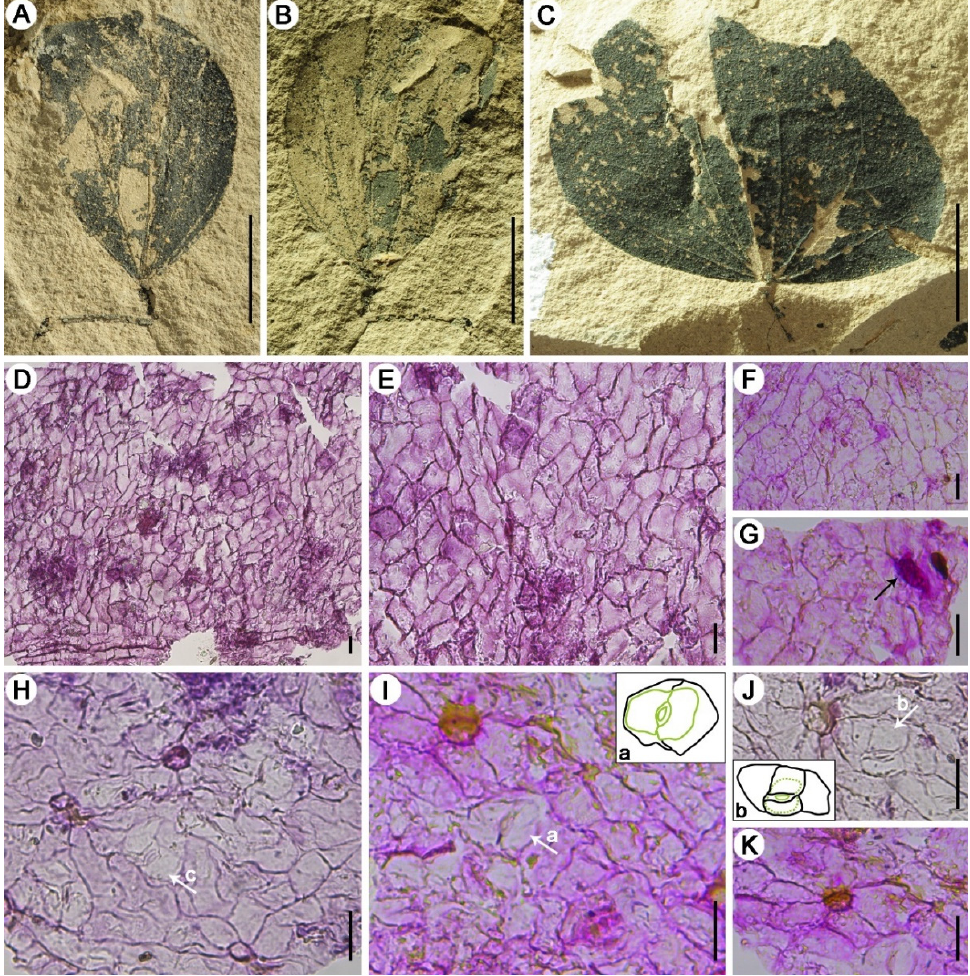
Figure 5. Leaf morphologies and cuticular structures of Bauhinia sp. (morphotype 2) from the Puyang Basin, Funing, Yunnan province. The scale bars represent 1 cm for leaf fossils and 20 μ m for cuticle images. ( A – C ) Leaves of Bauhinia sp. The cuticle images in D, E, H, and J are from the fossil specimen in C; F, G, I, and K are from the fossil specimen in A. ( D – G ) Adaxial cuticle showing straight arched epidermal walls. The black arrow in G indicates a single-celled trichome base. ( H – J ) Abaxial cuticle showing the orientation of stomata. White arrows indicate (a) paracytic stomatal complex with double-layered stomatal rim, (b) tetracytic stomatal complex, and (c) stomatal complex with double-layered stomatal rim. Line drawings illustrate (a) the paracytic stomatal complex indicated with white arrow a, (b) the tetracytic stomatal complex indicated with white arrows b. The green lines indicate stomata, the dashed green lines indicate indistinct sunken guard cells, and the black lines indicate subsidiary cells. ( K ) Single-celled trichome base of abaxial cuticle. A, FN0411a; B, FN0411b; C, FN0292.